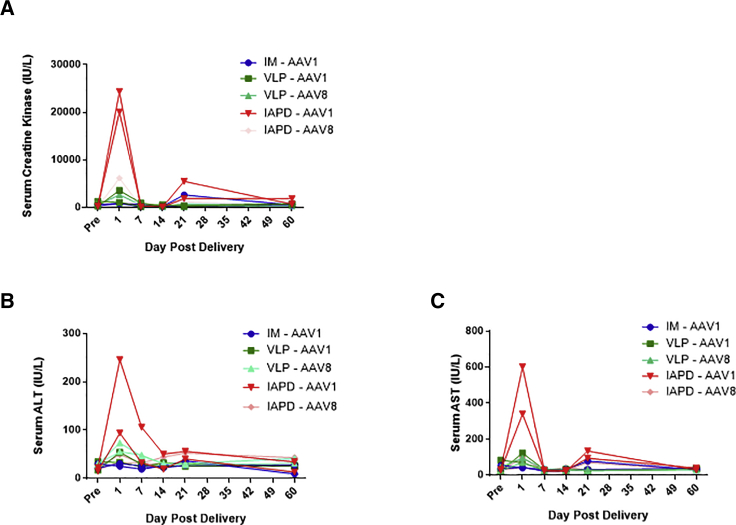
Serum Creatine Kinase and Liver Transaminase Levels following rAAV Rhesus AAT-c-myc Delivery(A) Serum levels of creatine kinase (CK), a marker of myocyte damage. (B) Serum levels of alanine aminotransferase, a transaminase that increases in the serum following hepatocellular damage. (C) Serum levels of aspartate aminotransferase, a transaminase that increases in the serum following hepatocellular damage. IM, intramuscular; IAPD, intra-arterial push and dwell; VLP, venous limb perfusion; ALT, alanine aminotransferase; AST, aspartate aminotransferase; AAV1 and AAV8, AAV capsid types delivered. n = 2 per group.